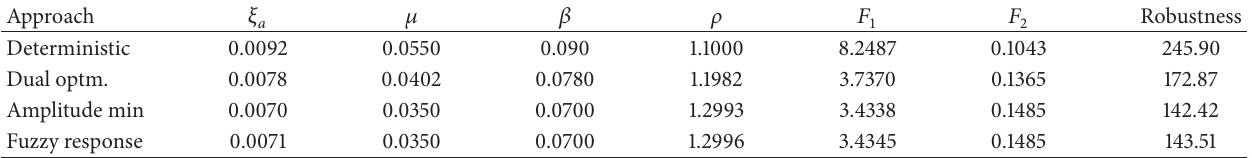
Table 4: Optimization results obtained by the nDVA design problem.